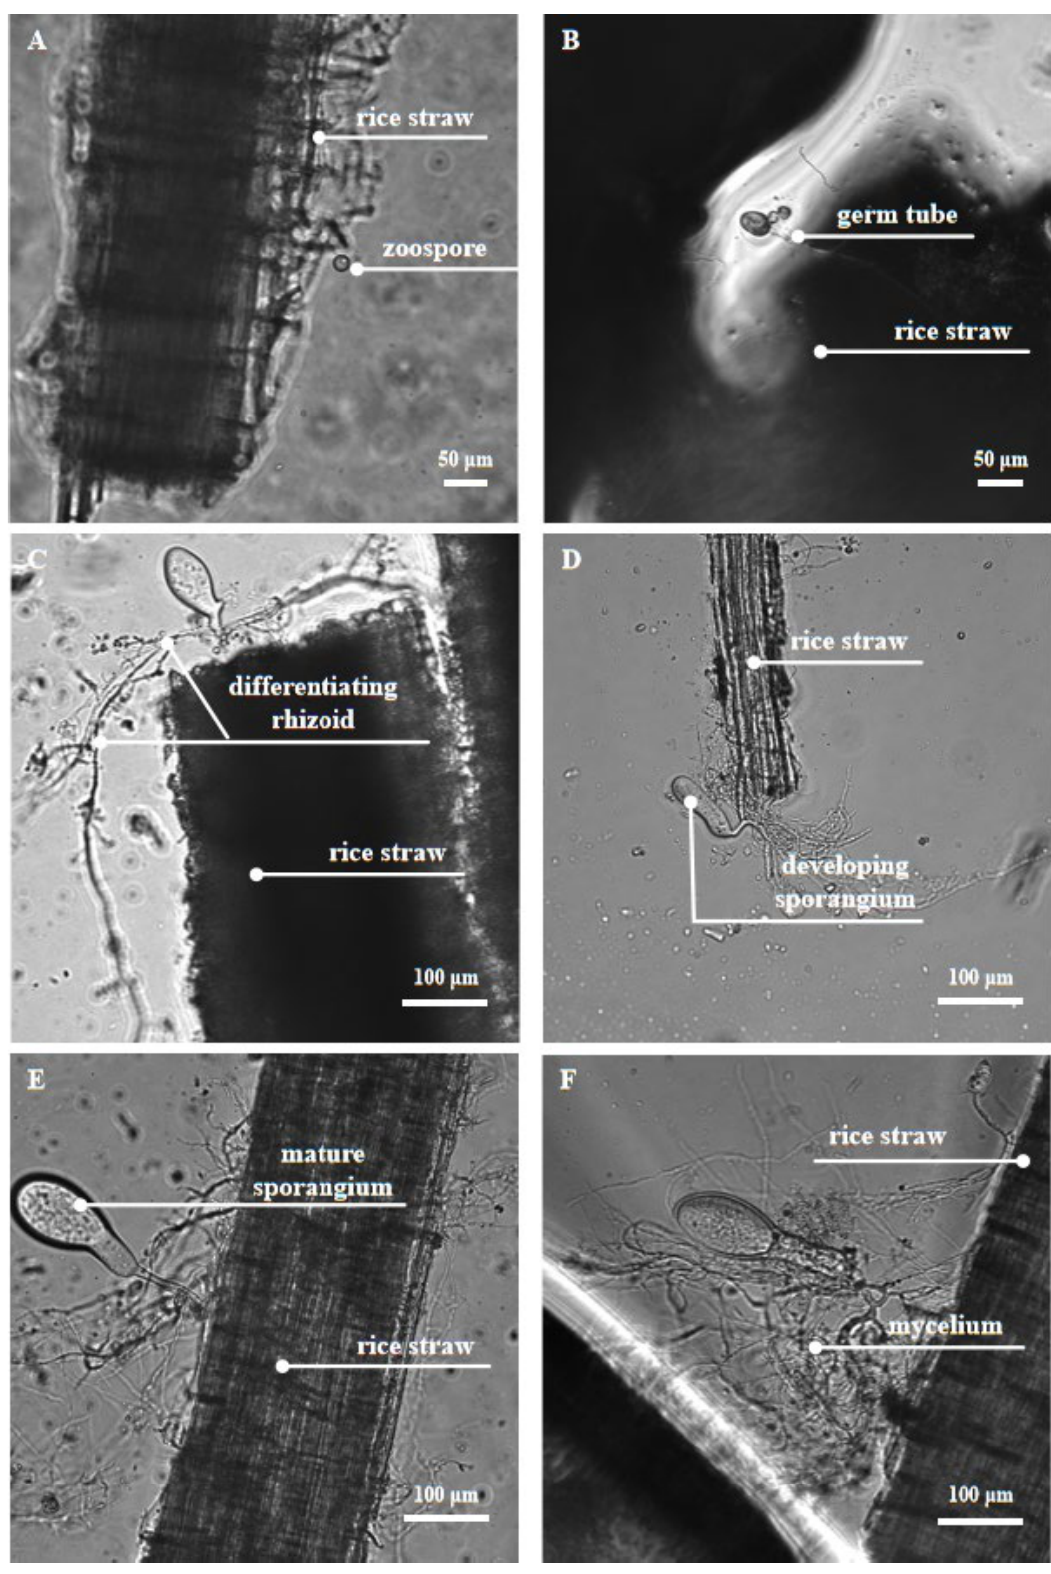
Figure 1. Anaerobic fungus Pecoramyces sp. F1 under the phase contrast microscope. The anaerobic fungus Pecoramyces sp. F1 undergoes the growth stages of zoospore attachment ( A ), rhizoid growth and penetration into the rice straw surface ( B – F ), and sporangium development and maturation ( C – E ).